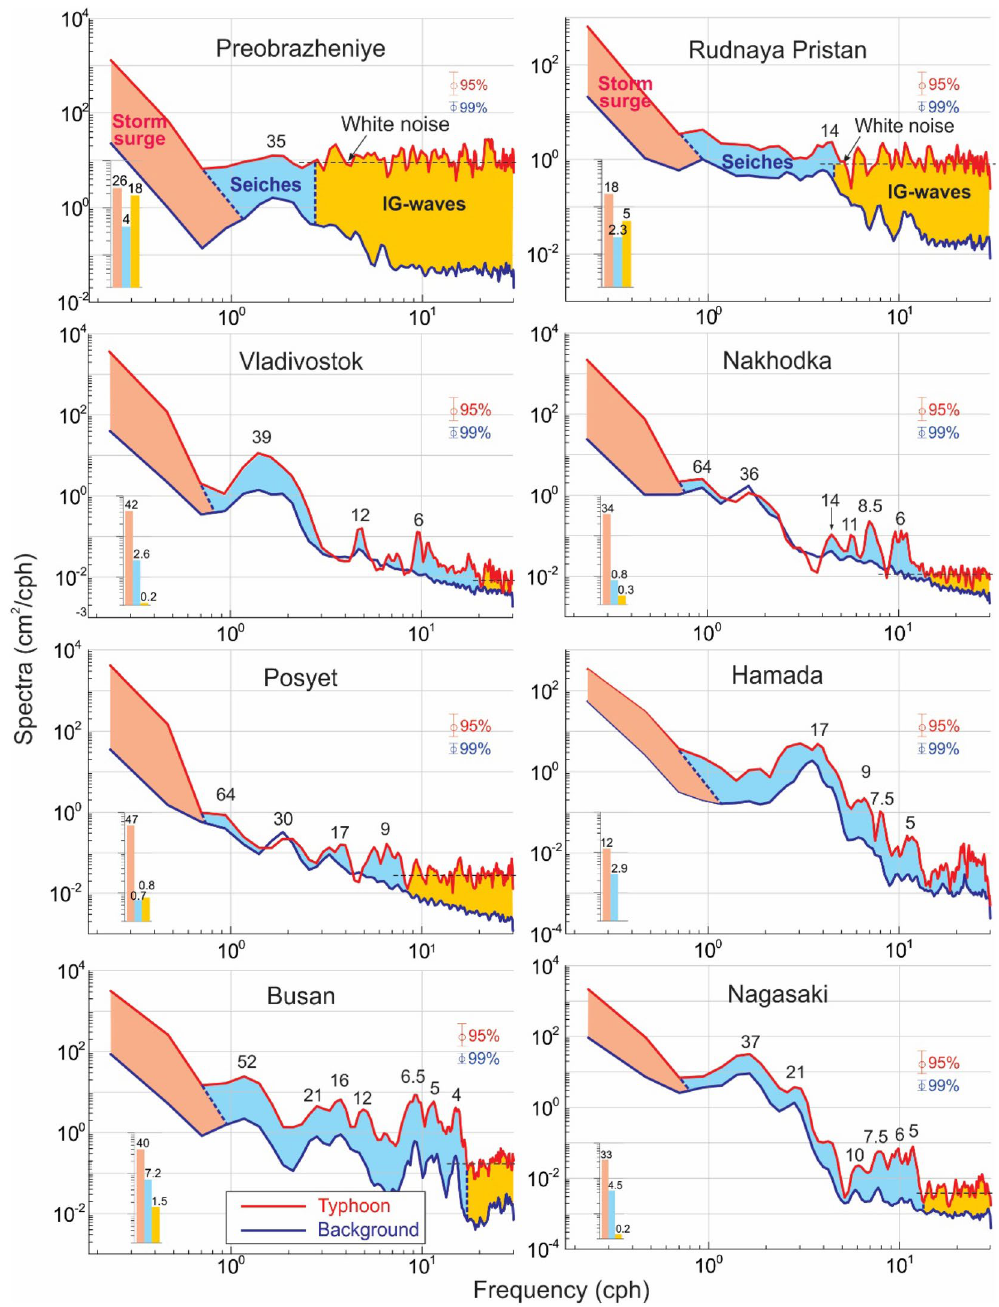
Figure 5. Spectra of background (pre-typhoon) and 2020 Typhoon Maysak sea level oscillations for eight 1-min tide gauge records from the coasts of Japan, South Korea, and Russia. Periods (in min) of the main spectral peaks are indicated. The 95% confidence level applies to the typhoon spectra, the 99% confidence level to the background spectra. The shaded areas denote the energy of three types of typhoon-generated oscillations: (1) Storm surge (peach), (2) storm seiches/meteotsunamis (light blue), and (3) infragravity (IG) waves (dark yellow); the bars in the left corners of each plot show the corresponding variances (in cm 2